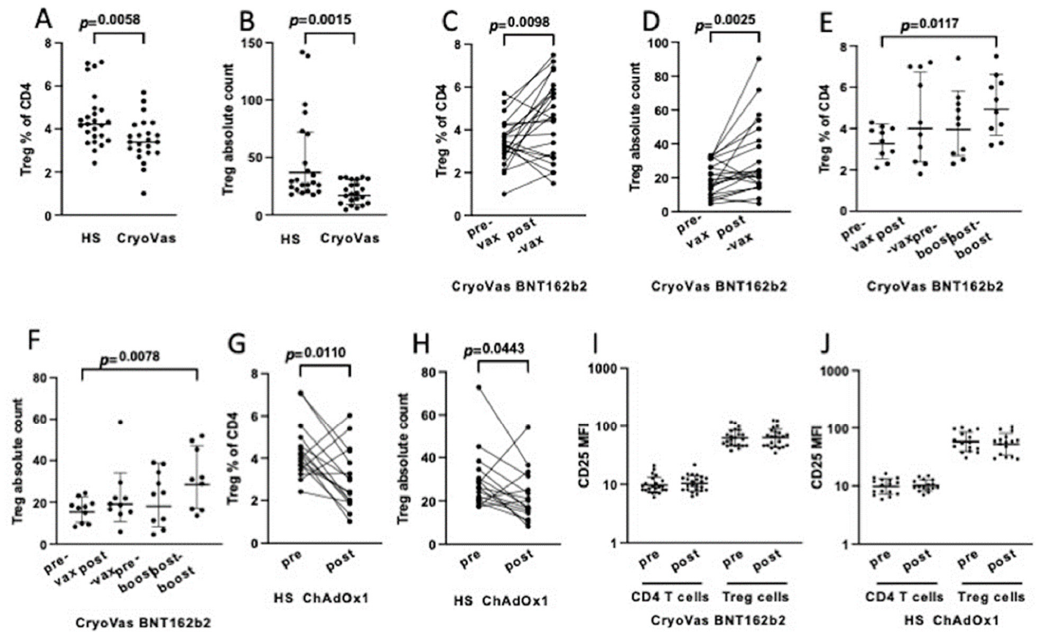
Figure 2. The BNT162b2 mRNA vaccine drives an increase and the ChAd Ox1 nCoV-19 adenovirus- vectored vaccine a decrease of CD4 pos CD25 high Treg cells. ( A ) The frequency among CD4 pos T cells and ( B ) the absolute count of Treg cells are significantly reduced in patients with CryoVas compared to healthy subjects (HS). ( C ) The frequency and ( D ) the absolute count of Treg cells increase in CryoVas patients after the second dose of BNT162b2. Findings in 10 CryoVas patients who received a booster dose of BNT162b2 mRNA vaccine 6 months after the second dose show that ( E ) the frequency and ( F ) the absolute count of Treg cells increase significantly after booster vaccination compared to pre-vaccination (pre-vax); none of the other comparisons reaches statistical significance. ( G ) The frequency and ( H ) the absolute count of Treg cells decrease in healthy subjects after the second dose of ChAd Ox1 nCoV-19 vaccine. ( I , J ) CD25 mean fluorescence intensity (MFI) in CD4 pos CD25 neg T cells and in CD4 pos CD25 neg Treg cells, before and after vaccination, in ( I ) CryoVas patients vaccinated with BNT162b2 and ( J ) in healthy subjects vaccinated with ChAdOx1 nCoV-19.